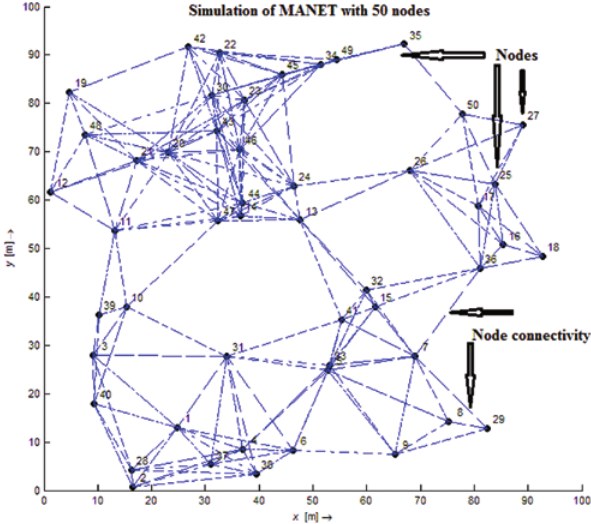
Figure 1: Simulation of MANET of 50